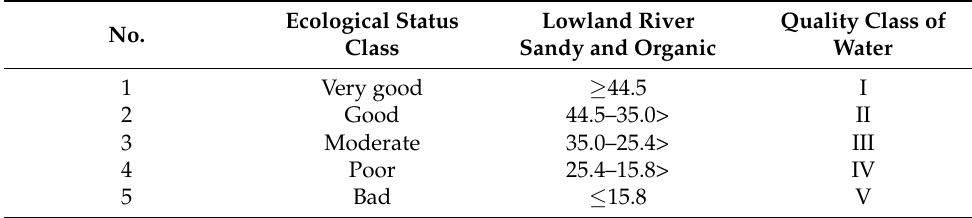
Table 2. The classification of water quality based on Macrophyte Index for Rivers for sandy type of a river